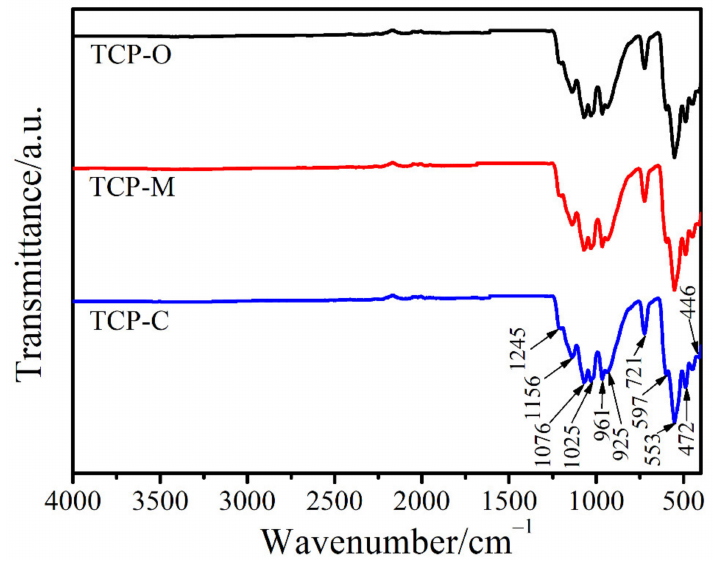
Figure 10. FTIR spectra of TCP-C, TCP-M and TCP-O